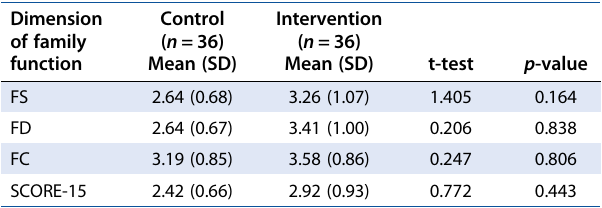
Table 2: Baseline mean family function scores of participants across study groups Dimension of family function